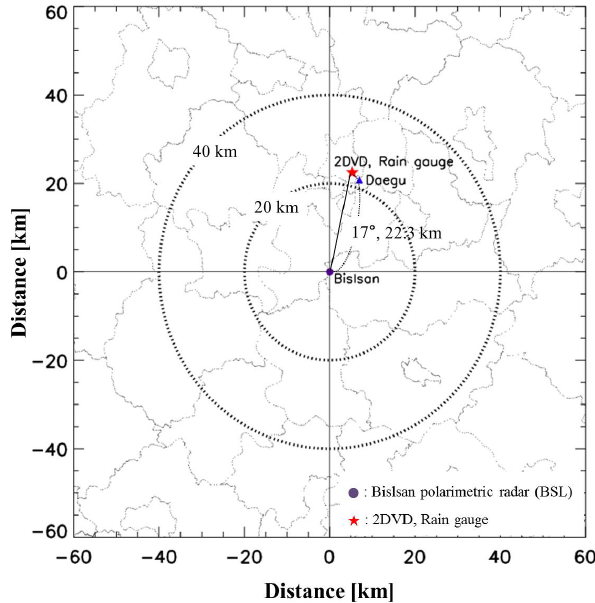
Figure 1. The locations of the Bislsan polarimetric radar and the 2DVD at the rain gauge